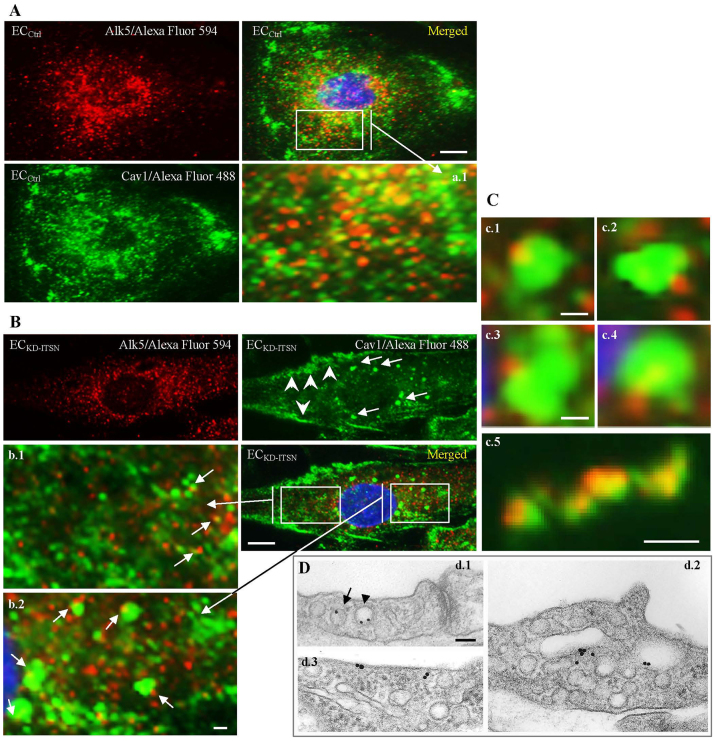

Endocytic deficiency caused by KD-ITSN alters Alk5 endocytic trafficking.Endocytic deficiency caused by KD-ITSN alters Alk5 endocytic trafficking. (A,B) Alk5 (Alexa Fluor 594) and cav1 (Alexa Fluor 488) double immunofluorescence of ECCtrl revealed strong, fine puncta for both cav1 and Alk5; in ECKD-ITSN (B, arrowheads), cav1 accumulates at the cell periphery. The merged images reveal significant colocalization of Alk5 and cav1 in ECCtrl (A,a1); however Alk5 and cav1 colocalization is more limited in ECKD-ITSN (B, merged image and inset b.1, arrows). Large fluorescent puncta immunoreactive to both cav1- and Alk5-specific antibodies (inset b.2, arrows) were detected inside the cell. (C,c.1–c.4) Gallery of magnified Alk5 and cav1 double-positive structures present in ECKD-ITSN; highly magnified cav1 and Alk5-positive puncta in ECCtrl (c5) are shown for comparison. (D) Pre-embedding EM immunocytochemistry demonstrates the association of 8-nm gold particles conjugated to the Alk5 antibody with caveolae (d1, arrow) and CCVs (d1, arrowhead) in wild-type mice. In KD-ITSN specimens, gold particles label the endothelial plasma membrane (d3), as well as the enlarged endocytic or tubulovesicular structures (d2). Scale bars: 10 µm (A,B), 5 µm (b.1,b.2), 0.6 µm (c.1), 0.75 µm (c.2), 1.0 µm (c.3), 0.8 µm (c.4), 0.9 µm (c5), 100 nm (D). All data are representative of least three independent experiments.